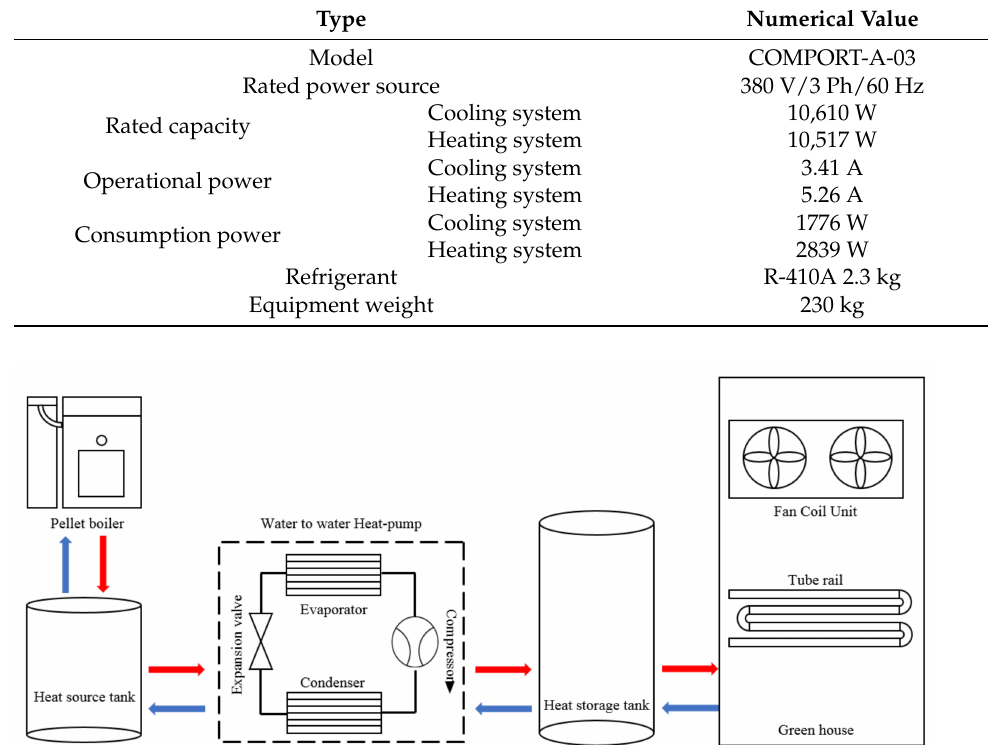
Table 3. Details of water-to-water heat pump.